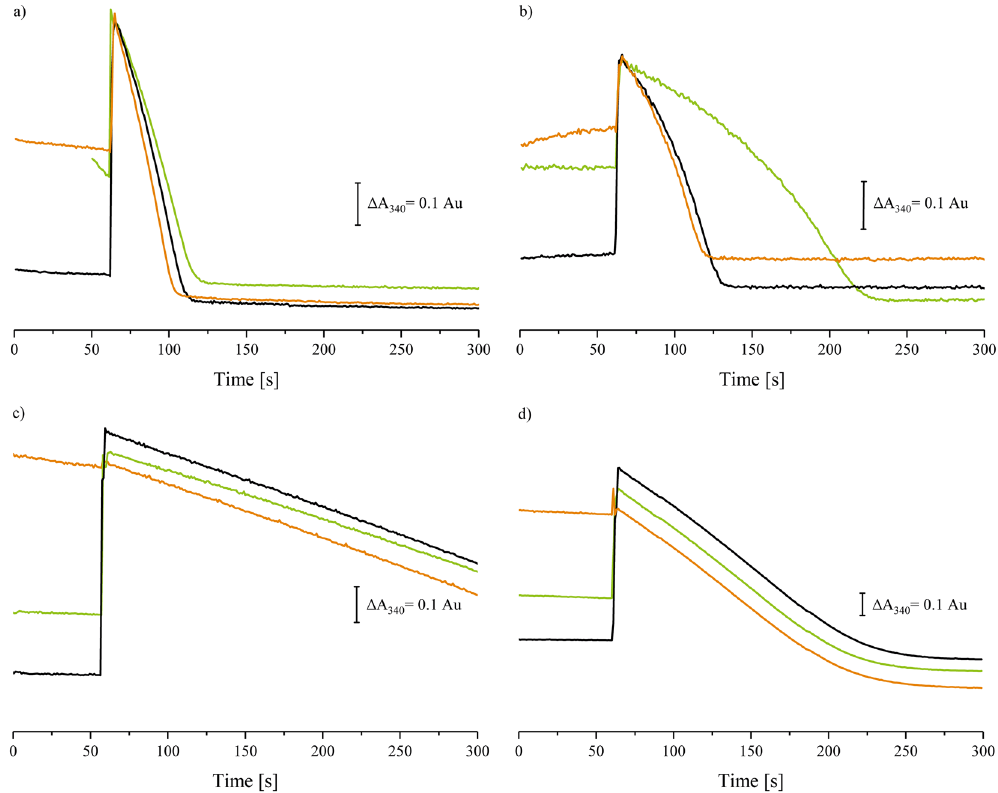
Figure 1. (d-)NADH:ferricyanide oxidoreductase activity of complex I in cytoplasmic membranes from E. coli ( a , b ) and T. thermophilus ( c ) and in bovine heart mitochondrial membranes ( d ). The reaction was either started by an addition of the enzyme (orange), NADH (black) or ferricyanide (green). The assay contained 40 µ g membrane proteins in 50 mm MES/NaOH, 50 mm NaCl, pH 6.0 ( a , b ), 50 mm Bis-Tris, pH 7.3 ( c ) and 20 mm Tris/HCl, pH 7.5 ( d ). The reaction rates were also determined in the presence of 10 µ m piericidin A ( b ). Virtually identical curves were obtained when the membranes were incubated with 20 mm KCN (data not shown). An addition of piericidin A and KCN did not alter the curves shown in ( c , d ) and are, therefore, not shown. An offset between the individual traces was introduced for a clearer representation of the curves. The membranes incubated with NADH show significant NADH oxidase activity ( a , green trace). Due to this, membranes were incubated with NADH for only 10 s before ferricyanide was